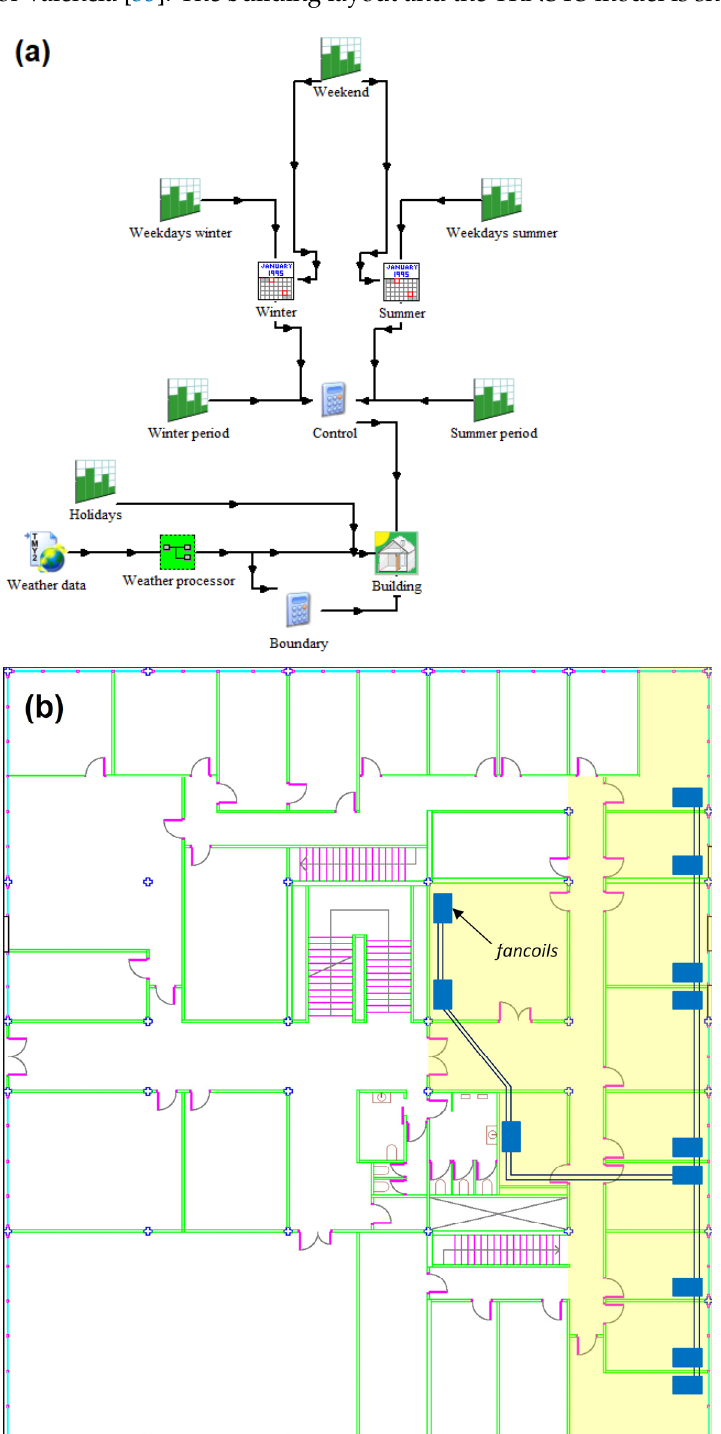
Figure 5. Building analyzed in the study: ( a ) TRNSYS building model and ( b ) fan coils’ distribution in the building [34].